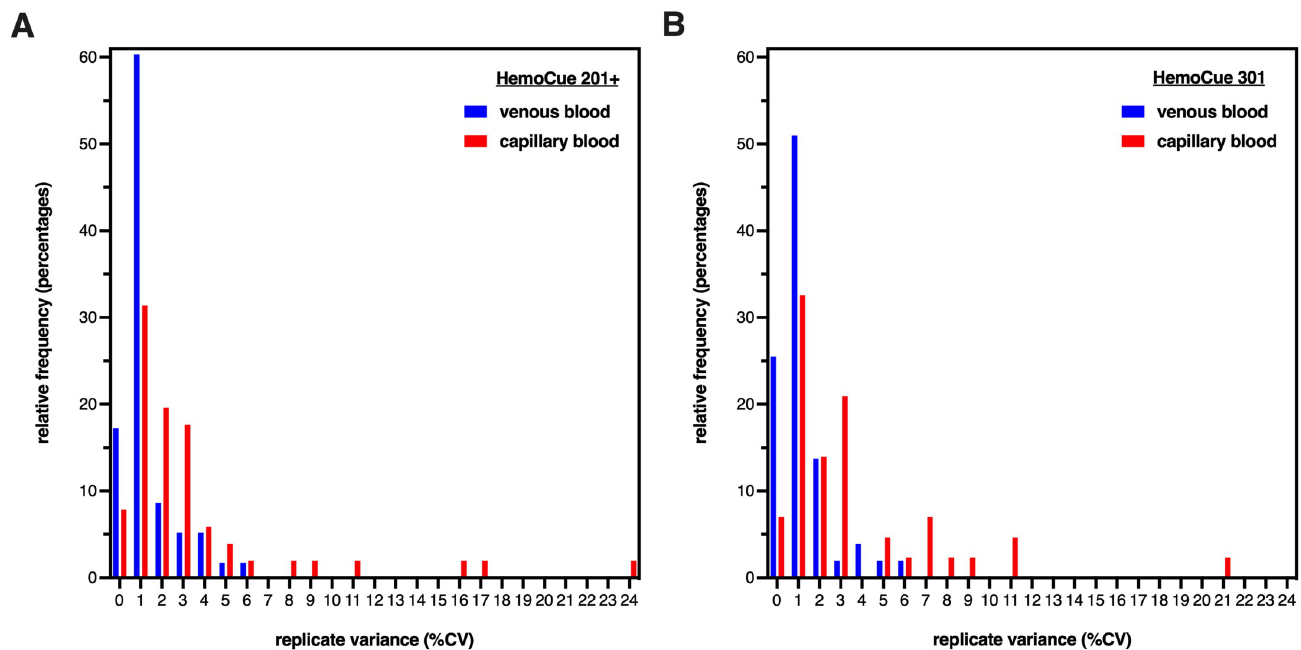
Fig 4. Variance in hemoglobin measurement replicates is greater from POC devices compared to automated hematology analyzers. Histograms of Hb values determined from replicate measurements of venous and capillary blood using ( A ) HemoCue 201+ and ( B ) HemoCue 301. For HemoCue 201+, the mean CV was 1.42% and the maximum CV was 6.04% (n = 57) for venous samples (blue), whereas the mean CV was 4.00% and the maximum CV was 24.96% (n = 54) for capillary samples (red). For HemoCue 301, the mean CV was 1.33% and the maximum CV was 5.52% (n = 50) for venous samples (blue), whereas the mean CV was 4.01% and the maximum CV was 20.89% (n = 48) for capillary samples, The reference values for mean CV of replicate Hb measurements using ADVIA-2120 is